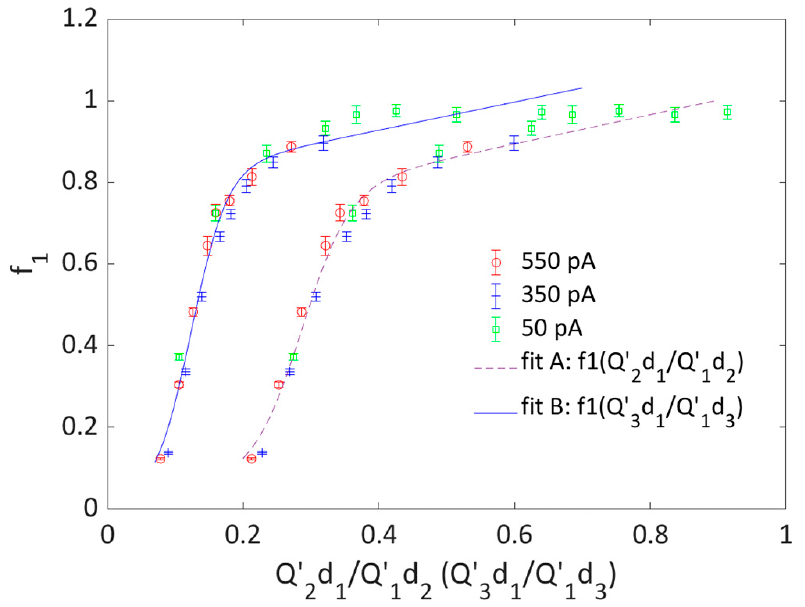
Figure 9. Calibration curves measured for chamber 1 as a function of Q (cid:2924)(cid:4593) d 1 / Q (cid:2869)(cid:4593) d n . Fit A describes the results achieved using data from chamber 1 and chamber 2, while fit B describes the data from chamber 1 and chamber 3. The color indicates the beam intensity.